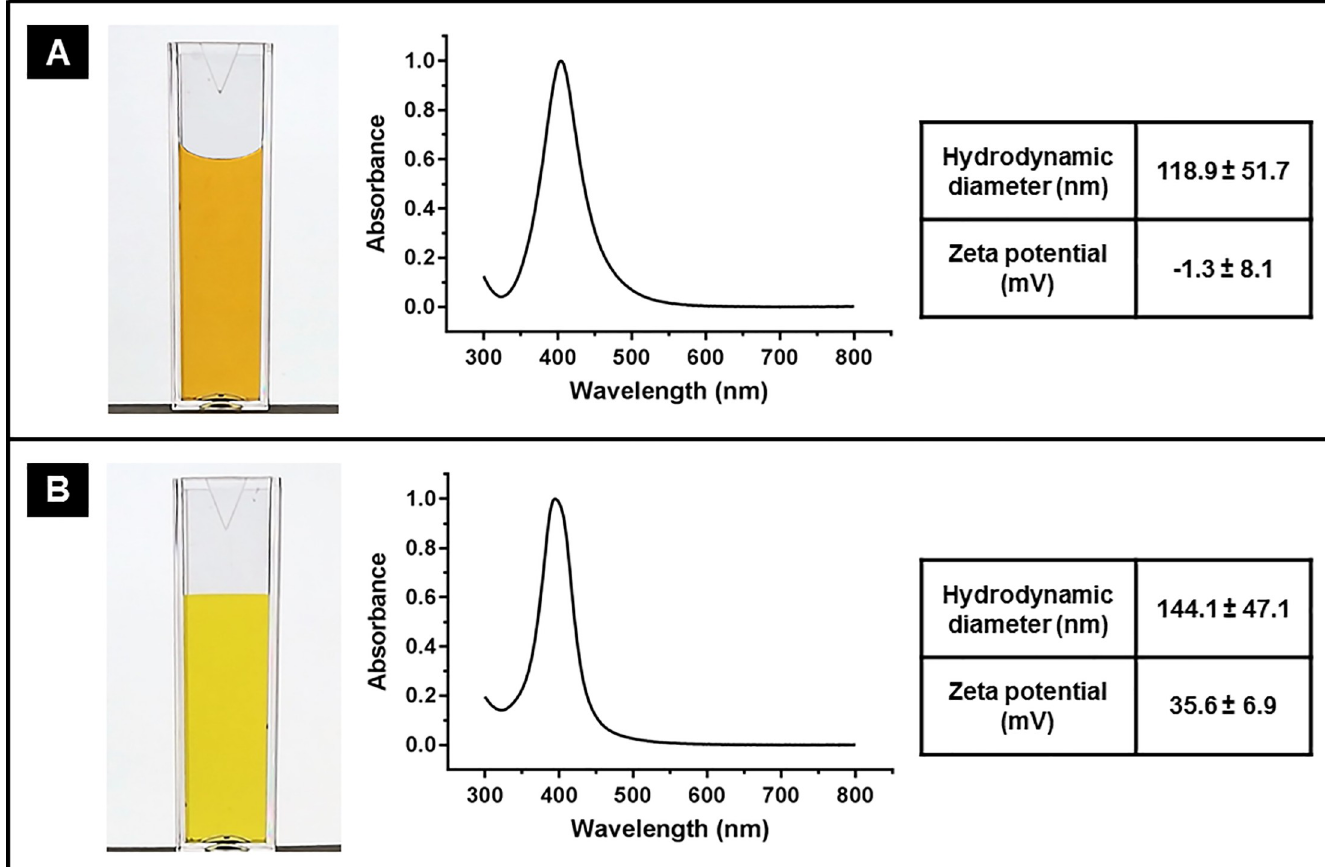
Fig 2. Photograph, normalized UV-vis spectrum, hydrodynamic diameter and zeta potential of (A) PVA-AgNP and (B) PAH-AgNP.